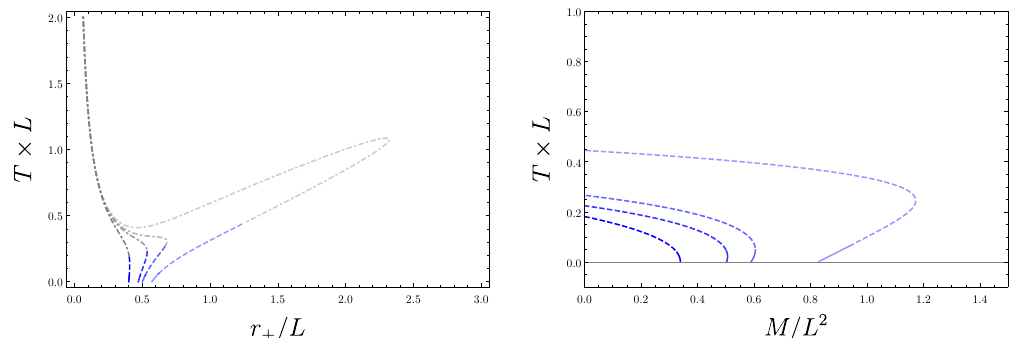
Figure 13 . Five-dimensional black hole properties in the grand canonical ensemble II . Here we show plots of temperature vs. horizon radius (left) and temperature vs. mass (right) for µ/µ corresponding to µ < 79 L 4 / 1890, providing an example of the behaviour when large black holes − do not exist. The curves correspond to Φ = 0 , 1 . 5 , 1 . 7 , 2 in order of decreasing opacity (or left to right through a horizontal slice). The dashed blue curves indicate that the Wald entropy is negative, while the dot-dashed grey curves in the left plot indicate negative